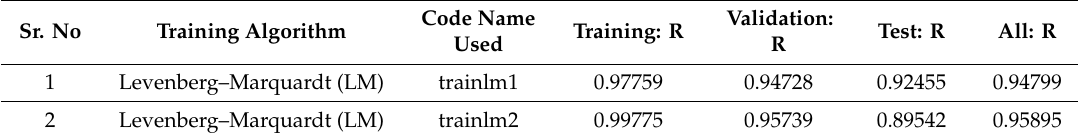
Figure 2. Regression plot obtained by training and optimization of the genetic algorithm (GA)–ANN tool. The plots represent the correlation between outputs and targets corresponding to the optimal Levenberg–Marquardt algorithm ( a ). Convergence of GA–ANN for maximizing pullulan weight ( b ). Table 1. Significant regression ‘R’ values corresponding to Levenberg–Marquardt training algorithms ‘trainlm 1 and 2 ′ .